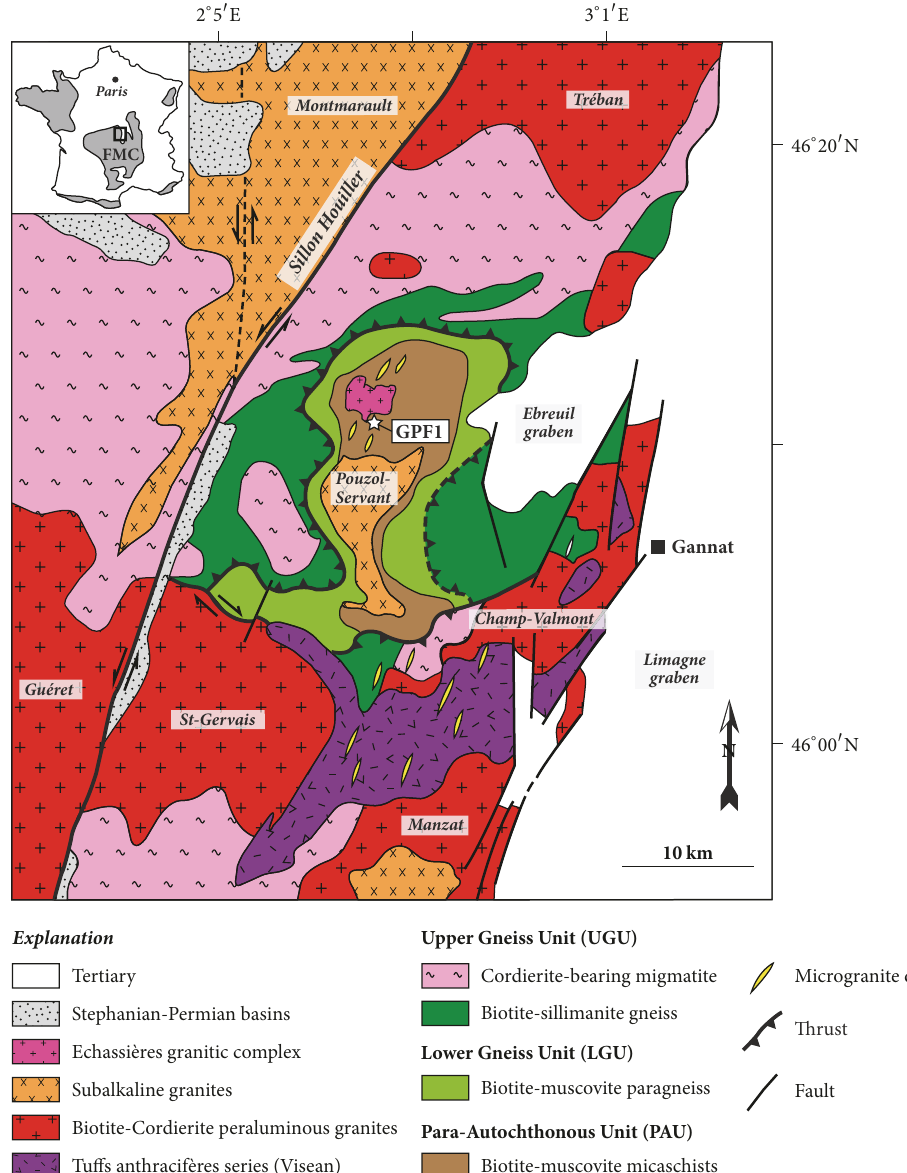
Figure 1: Geological setting of the Echassi`eres granitic complex in the NE part of the French Massif Central (FMC) (modified from [11]). The location of the GPF1 drill hole from the “G´eologie Profonde de la France” program is indicated.